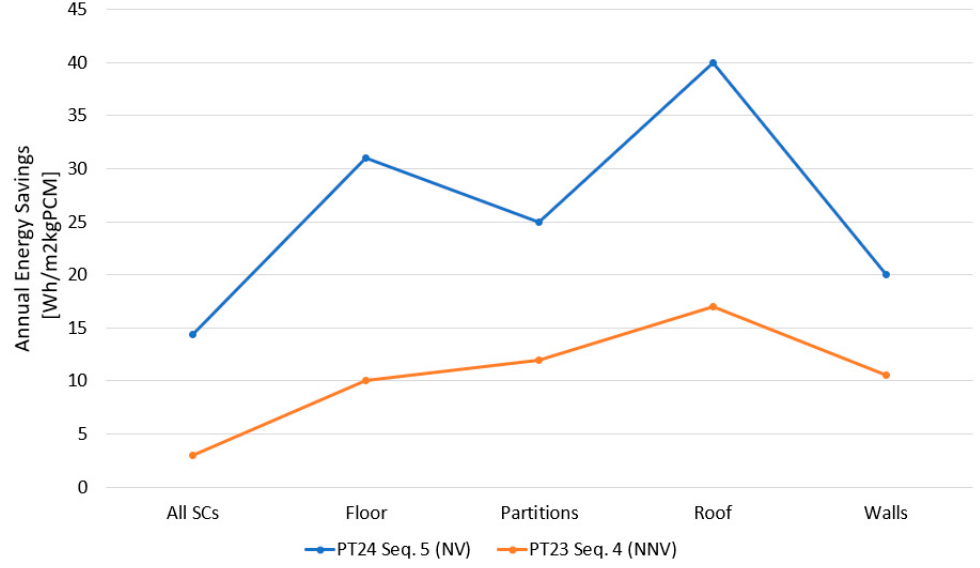
Figure 15. Electricity saving potential per kg PCM for different equipped surfaces of building B.